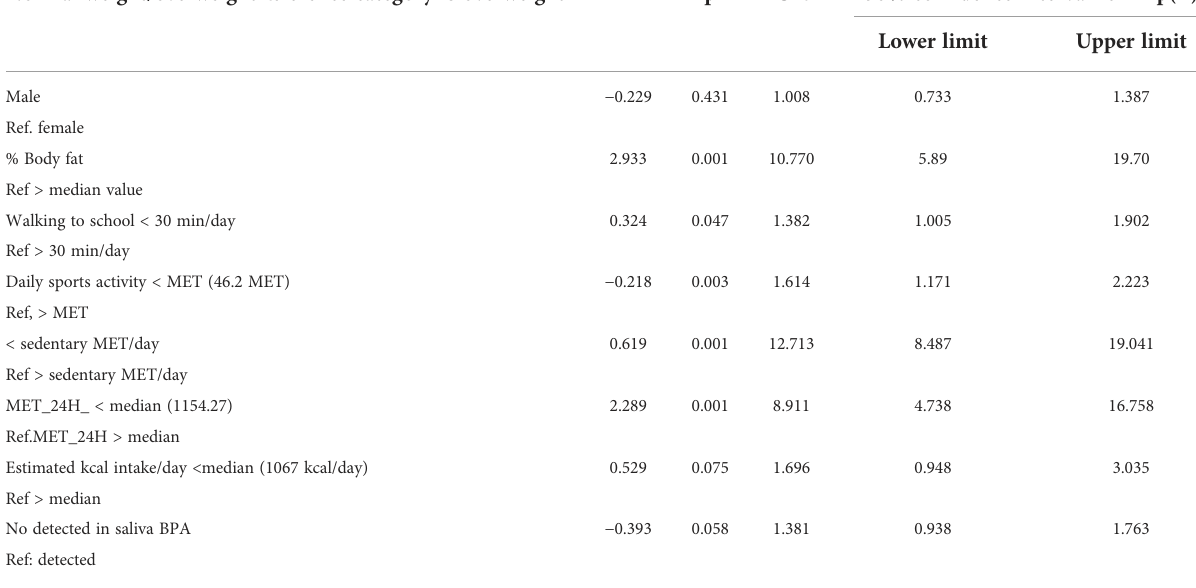
TABLE 3 Logistic regression analysis to determine factors associated with normal weight/overweight. Normal weight/overweightReference category is